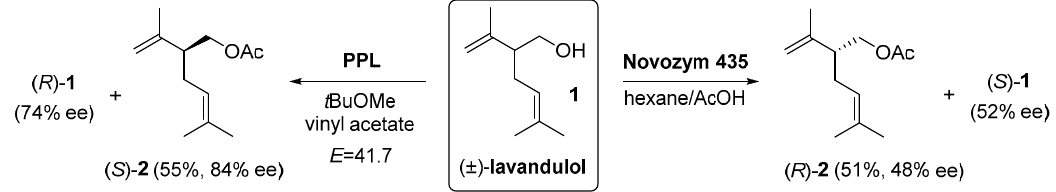
Figure 1. The PPL and Novozym 435 mediated resolution of the racemic fragrance lavandulol ( 1 ).